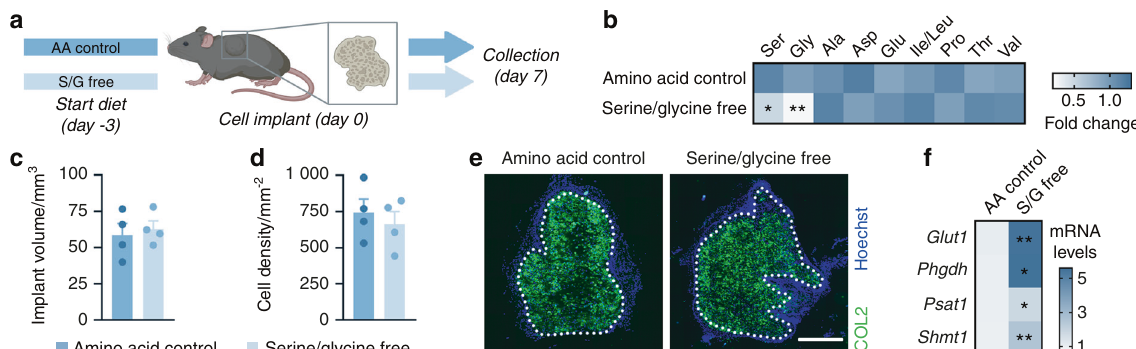
Fig. 5 Serine/glycine-free diet feeding does not affect chondrocyte function in vivo. a Schematic overview of the experimental setup. Chondrogenically primed progenitor cells were ectopically implanted into mice fed an amino acid (AA) control diet or a serine/glycine (S/G)-free diet. Ossicles were collected 7 days after implantation. b Serum metabolite levels in mice fed the control or serine/glycine-free diet ( n = 4). Ser represents serine, Gly represents glycine, Ala represents alanine, Asp represents aspartate, Glu represents glutamate, Ile represents isoleucine, Leu represents leucine, Pro represents proline, Thr represents threonine and Val represents valine. Volume ( c ) and cell density ( d ) of ectopic implants ( n = 4). e Type 2 collagen (COL2) immunostaining in ectopic implants ( n = 4). The scale bar represents 500µm. f Glut1 , Phgdh , Psat1 , and Shmt1 mRNA levels in ectopic implants ( n = 4). The data are presented as the means±SDs; * P <0.05 vs. AA control, ** P <0.01 vs. AA control (Student ’ s t